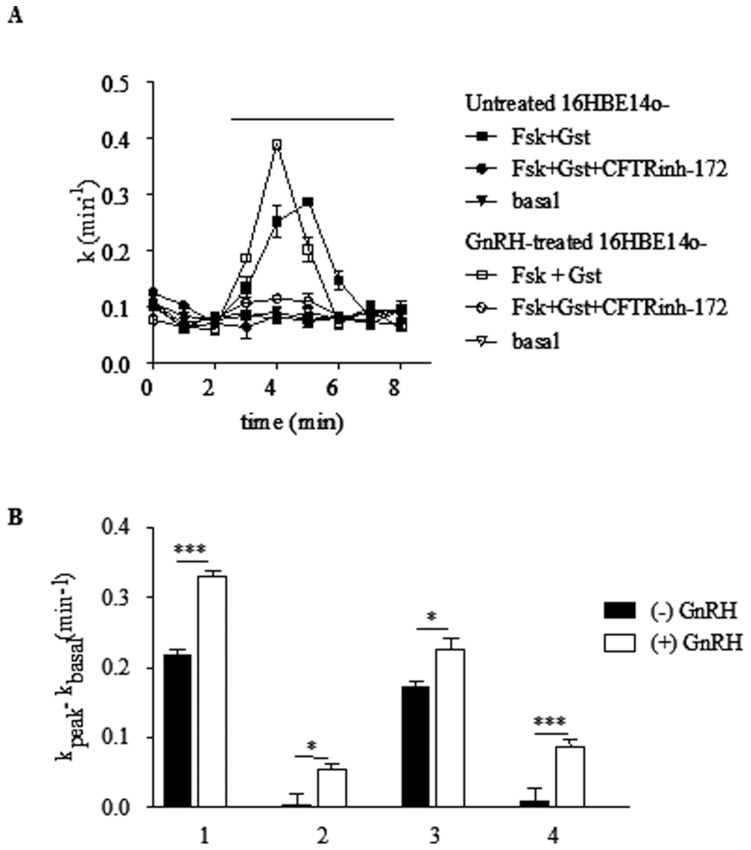
Activation of wild-type and F508del-CFTR chloride channel activity in cells treated by GnRH.
A. Example of mean traces showing the restoration of an iodide efflux in 16HBE14o- cells untreated or treated 1 h with 1 nM GnRH and stimulated by 10 µM forskolin and 30 µM genistein. B. Bar graph showing the enhancement of the chloride channel function of CFTR in 16HBE14o−, CFBE41o−, CFBE41o−/corr and CFBE41o−/F508del cells (1, 2, 3 and 4, respectively) using iodide efflux experiments. Histograms show the mean relative rate of iodide efflux in each cell type, with and without GnRH treatement. A significant increase is observed in the presence of GnRH (n = 4).